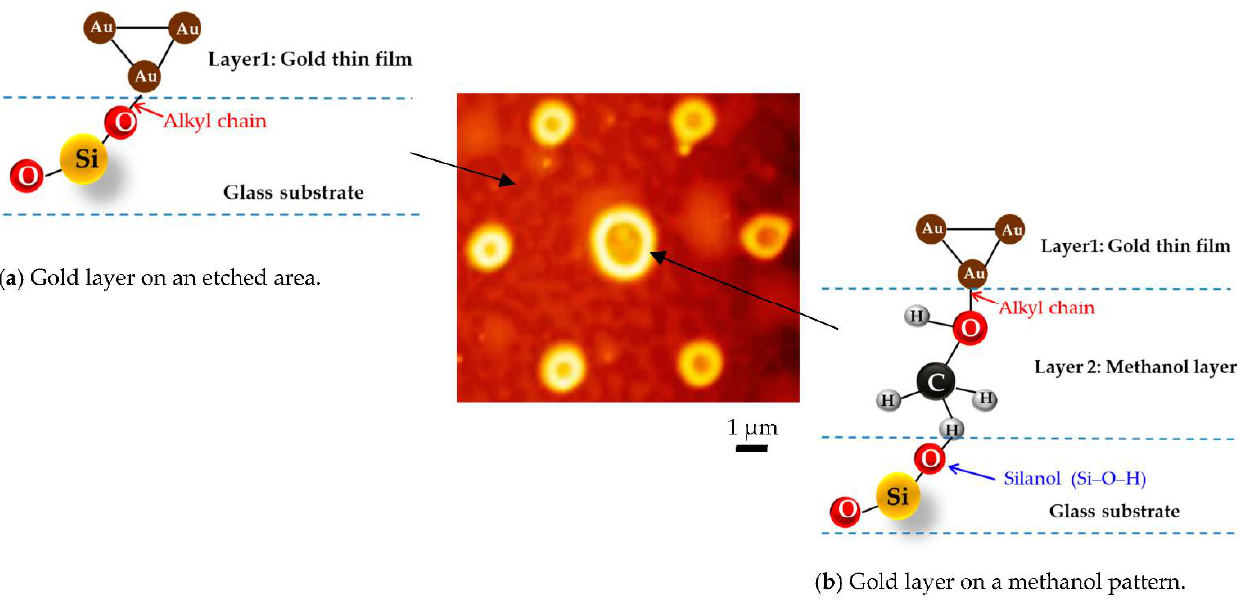
Figure 6. The chemical layers of the gold micro-ring structures on a glass plate. ( a ) gold layer on an etched area, ( b ) gold layer on a methanol pattern. etched area, ( b ) gold layer on a methanol